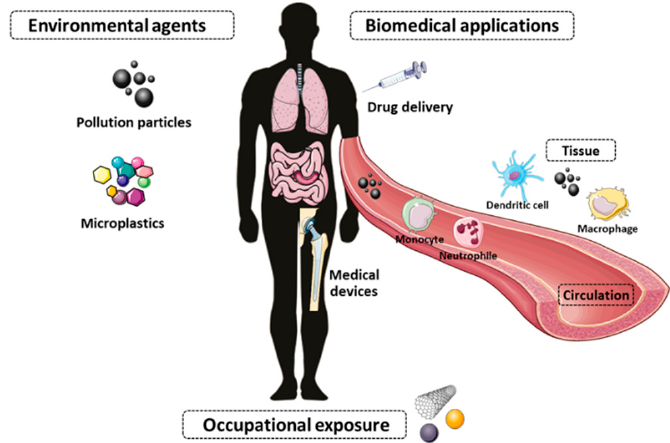
Figure 4. Exposure to nanomaterials activates the immune surveillance system. Nanomaterials used for industrial and biomedical applications or present in the environment can have a major impact on human, animal, and plant health. If nanoparticles penetrate anatomical barriers, cells of the innate immune system (e.g., macrophages, monocytes), found in circulation or locally in different tissues, recognize them. This may lead to nanoparticle degradation/elimination or modulate the body towards beneficial or detrimental responses. (Servier Medical Art,